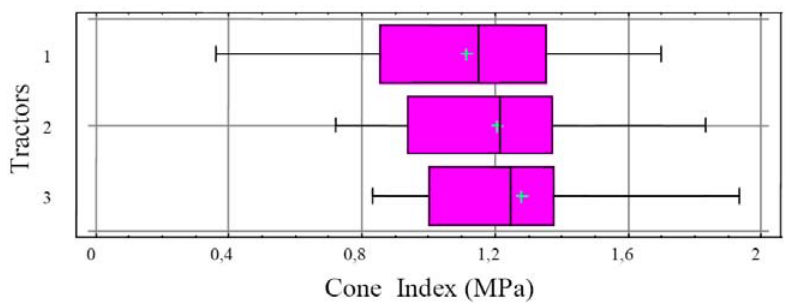
Figure 4. Box and Whisker Plot, Tractors type vs. Cone Index.